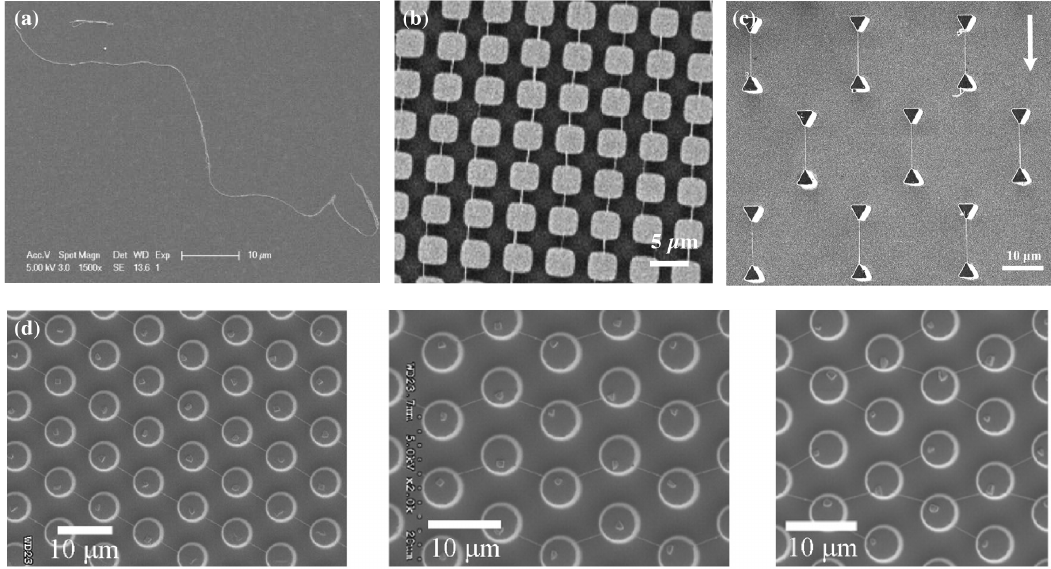
Figure 5. ( a ) Disordered deposition of a micellar nanowire on an unstructured surface, compared to ( b ) aligned nanowires after dewetting of microstructures (square pillars of 3.5µm in width, 2µm in gap, and 3µm in height) [29]. ( c ) Variation of the microstructure geometry yields different nanowire formations [48], also seen in ( d ), where a different flow direction angle of receding fluid in each picture additionally influenced the layout of resulting nanowires [47]. ( a – c ) reprinted from [29,48] with permission from Wiley; ( d ) reprinted from [47] with permission of AIP